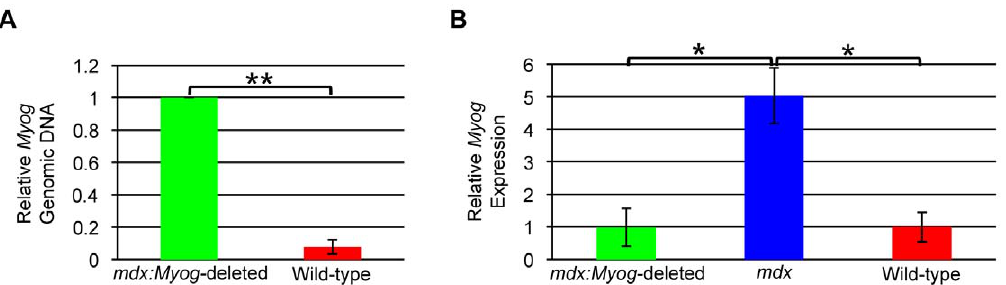
Figure 1. Reduced Myog genomic DNA and transcripts in mdx:Myog -deleted mice. (A) PCR genotyping reveals an efficient deletion (92%) of Myog genomic DNA in adult mdx:Myog -deleted mice (** p , 0.001). (B) Reduced abundance of Myog transcripts in adult mdx:Myog -deleted mice. Myog transcript levels in mdx mice were increased by 5-fold over those in wild-type mice (* p , 0.05). Myog transcript expression in mdx:Myog -deleted mice was equal to that of wild-type mice. (all groups, n=3 ). Error bars represent 1 standard deviation.